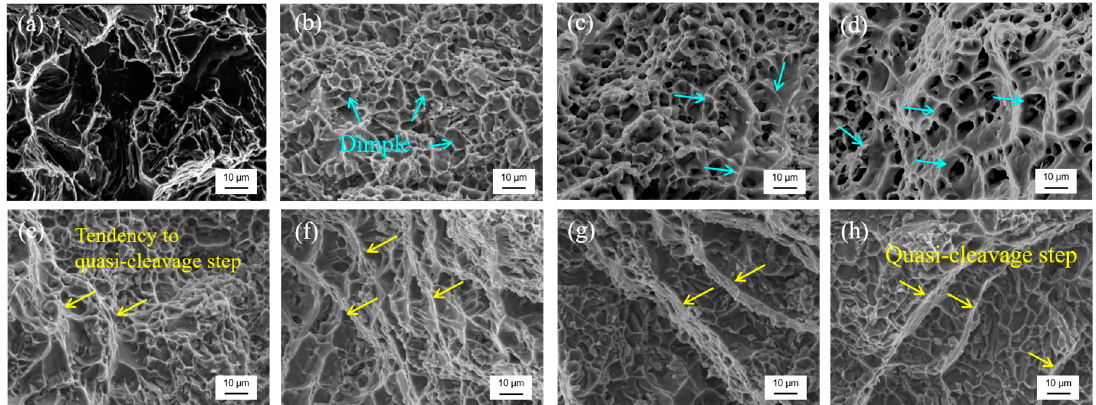
Figure 2. Fracture morphologies of the untreated alloy ( a ) [1] and Sc-Sr composite modified alloy under different temperatures: ( b ) 20 °C, ( c ) 100 °C, ( d ) 200 °C, ( e ) 0 °C, ( f ) − 20 °C, ( g ) − 40 °C, ( h ) − 60 °C.